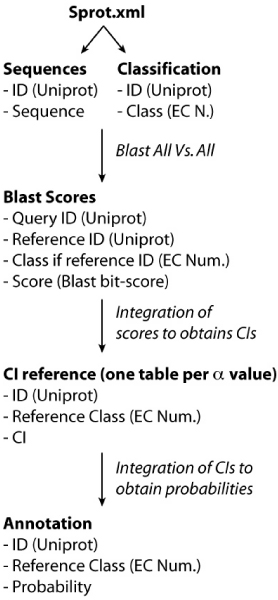
Schematic view of the CORRIE annotation framework. The only requirement for CORRIE is a classification of sequences. Here, we start with the classification of enzymes found in SwissProt. This enables us to create two tables, one for sequences and one for classes. From pairwise sequence comparisons we derive a score table, which describes all the classes hit by each sequence. BLAST scores are further integrated into correspondence indicators (CIs), which describe the relationship each sequence has with the classes it hits. Next, CIs are integrated to compute the probability that a sequence belongs to a particular class. The table "CI reference" is central to the framework as it constitutes a reference against which new proteins are compared and classified. This is illustrated in Figure 2.